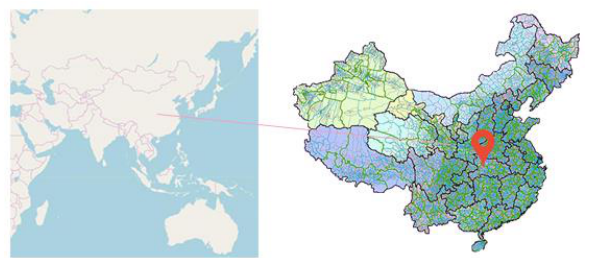
Figure 2. Location of study area